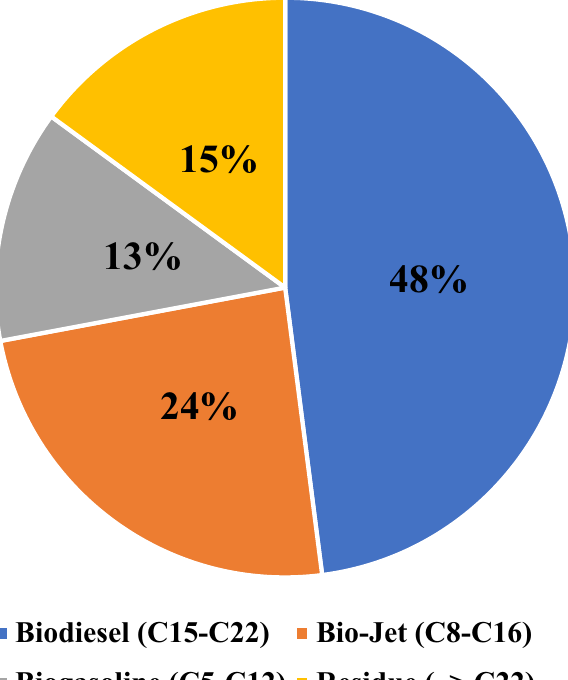
Figure 12. Hydrocarbon Contents of a Selected Sample liquid Product. (Temp. 400 °C, 50 bar, LHSV: 1 h -1